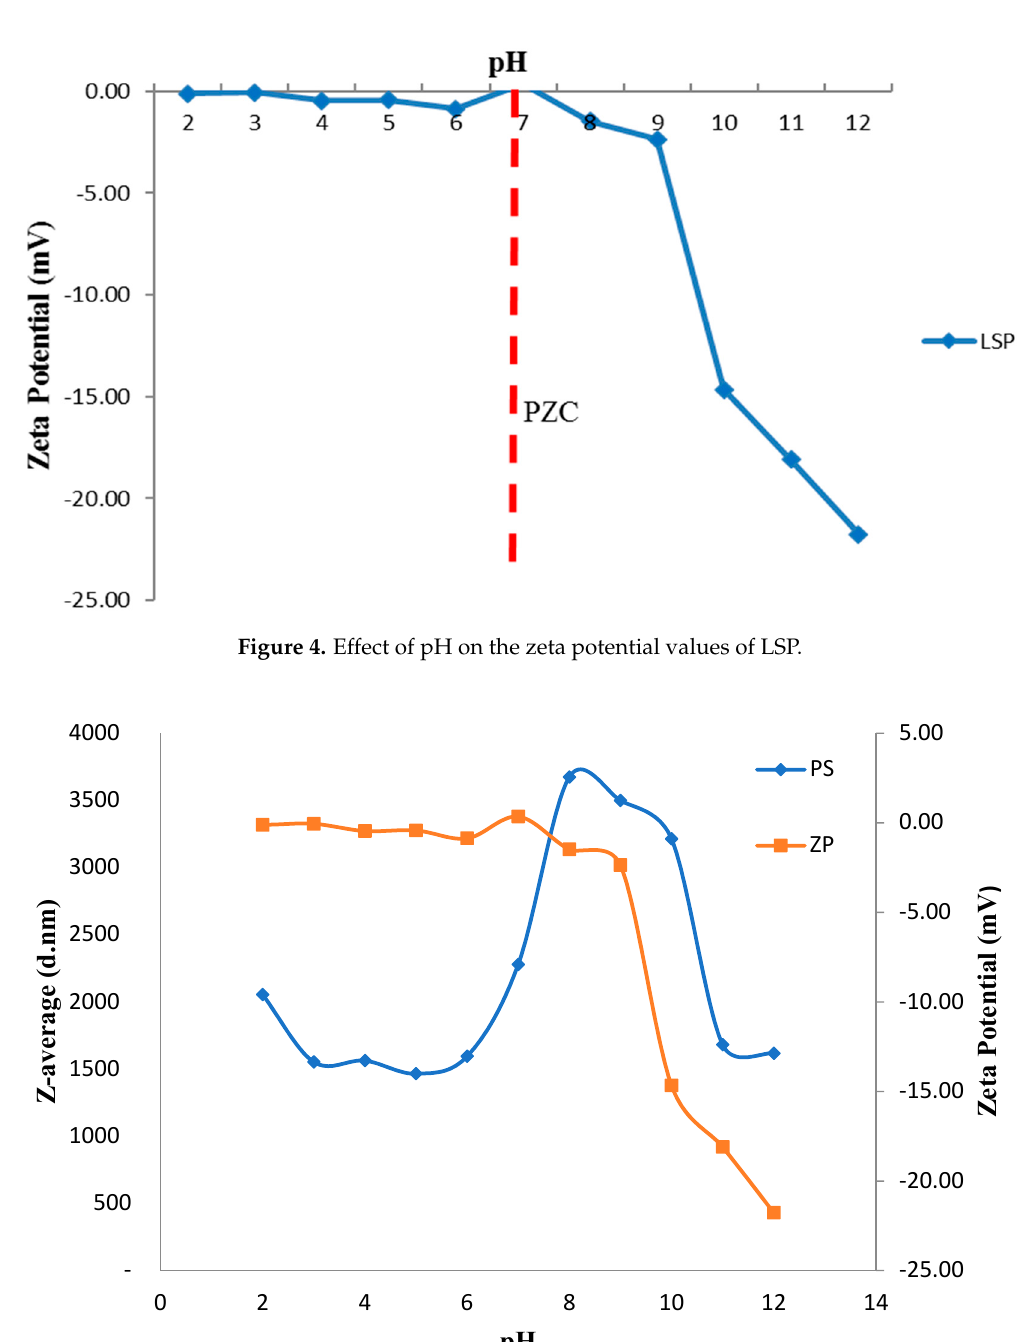
Figure 5. Zeta potential and z-average particle size variation with different pH values (PS is the particle size, ZP is the zeta potential).